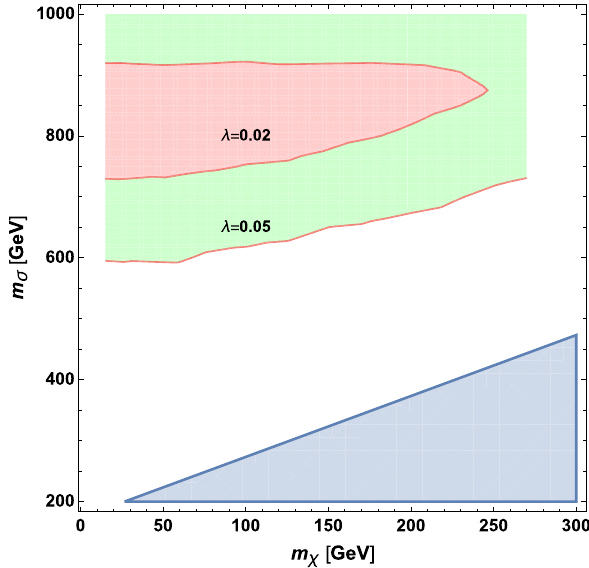
Fig. 5 Excluded regions at the 95% confidence level after reinterpret- ing the results of the CMS-B2G-12-022 analysis in the considered res- onant monotop model. The results are presented in the ( m σ , m χ ) plane, assuming BR t χ = 100%. The red area corresponds to the excluded parameter space region for λ = 0 . 02, while the green area (plus the red one) corresponds to the excluded region for λ = 0 . 05. There is no bound for λ = 0 . 01 or smaller. Finally, the blue region (the triangle area on the bottom right) is not considered as the model configuration does not feature any σ decay into a monotop system σ → χ